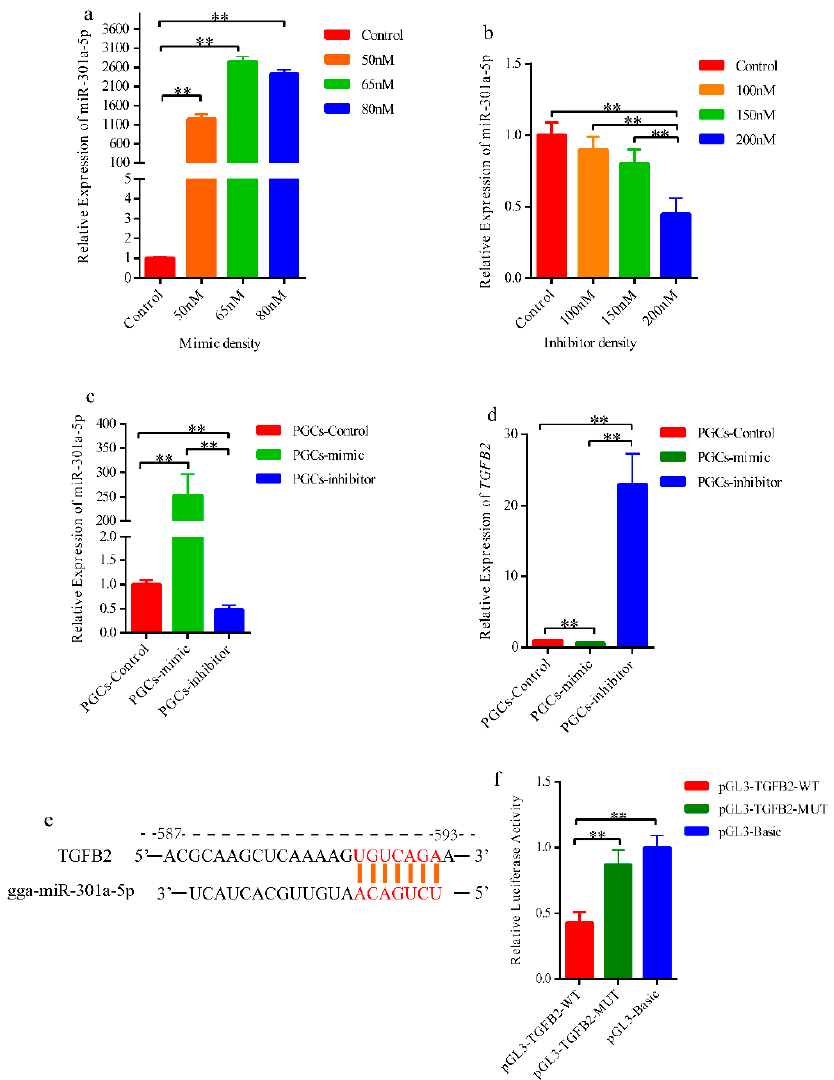
Figure 3. miR-301a-5p regulated TGFB2 in DF-1 and PGCs in chicken. ( a , b ) Quantitative real-time PCR analysis showing the effect of transfecting different miR-301a-5p mimic and miR-301a-5p inhibitor densities in DF-1; ( c , d ) quantitative real-time PCR analysis showing the decreased level of miR-301a-5p and TGFB2 in PGCs after transfection with a miR-301a-5p mimic and miR-301a-5p inhibitor; ( e ) binding site of miR-301a-5p in TGFB2 ; ( f ) results of the luciferase reporter assay revealing the relationship between miR-301a-5p and TGFB2 . Data shown as mean ± SEM, ** p < 0.01. 3.4. miR-301a-5p Regulates the TGFB Pathway by Directly Binding to TGFB2